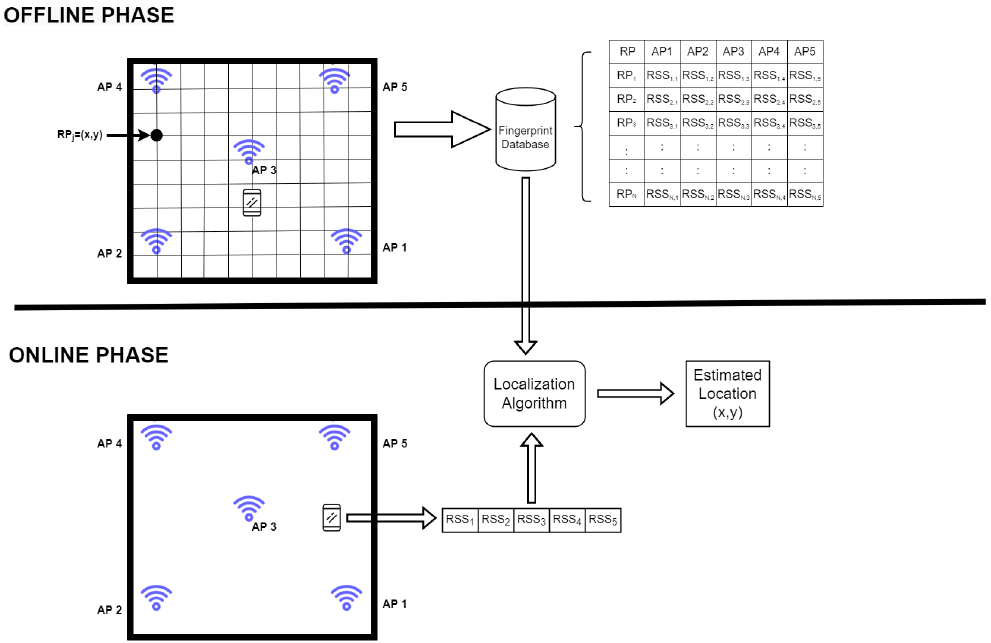
Figure 1. WLAN fingerprinting-based indoor positioning system. To simulate signal transmission over the channel between the AP and RP, a log-normal path loss model is employed. This model can be used for a wide range of environments and considers the random shadowing effects caused by different types of obstacles causing signal blockage. Shadowing effects cannot be ignored when modeling real environments. In indoor situations, path loss is affected by a variety of parameters, including distance ( D ), noise ( ζ ), physical barriers ( γ ), and human presence ( ρ ). Each barrier, whether a wall or a human, must have the resulting attenuation represented in the model. As a result, we use the extended log-normal path loss model in our simulations [38].